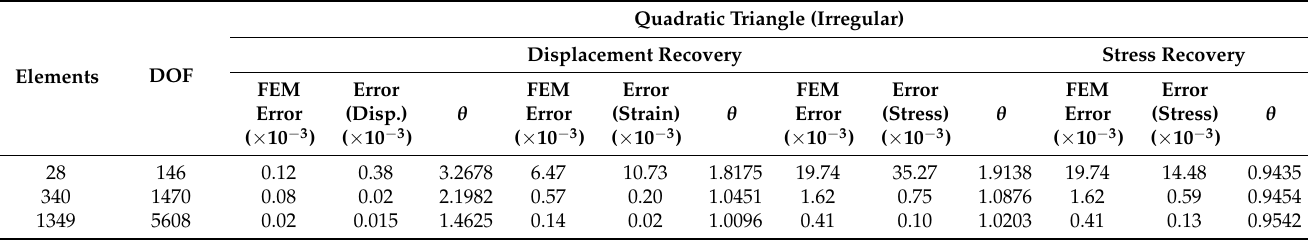
Table 4. Error in displacement, strain and stress (L 2 -Norm), and global effectivity ( θ ) in compressible elastic square plate example considering displacement and stress recovery